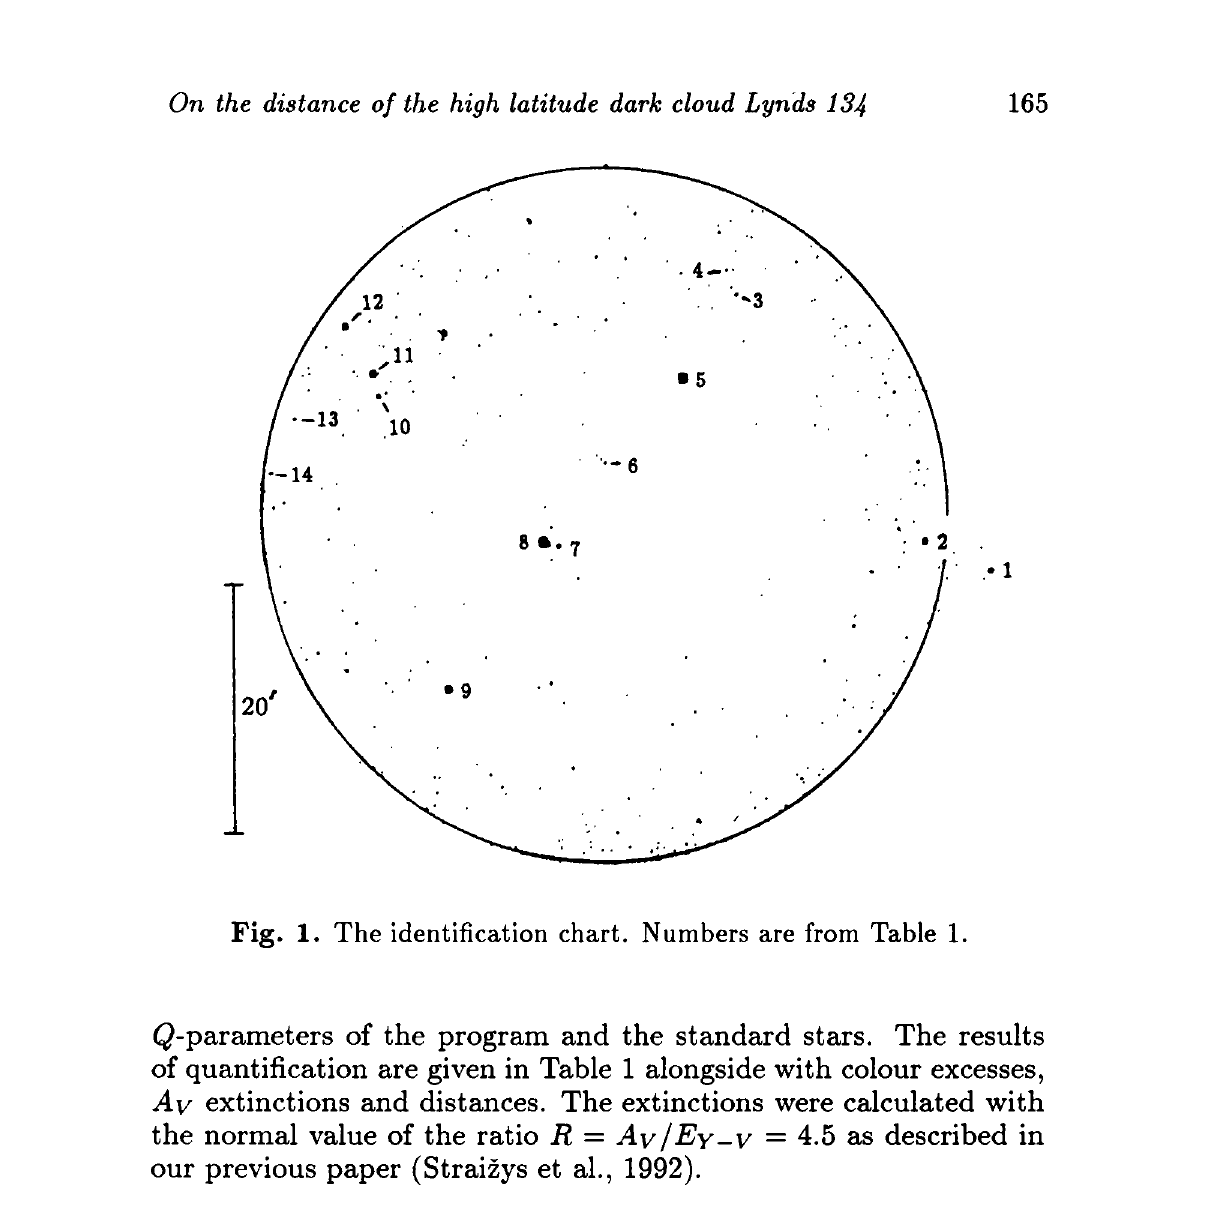
Fig. 1. The identification chart. Numbers are from Table